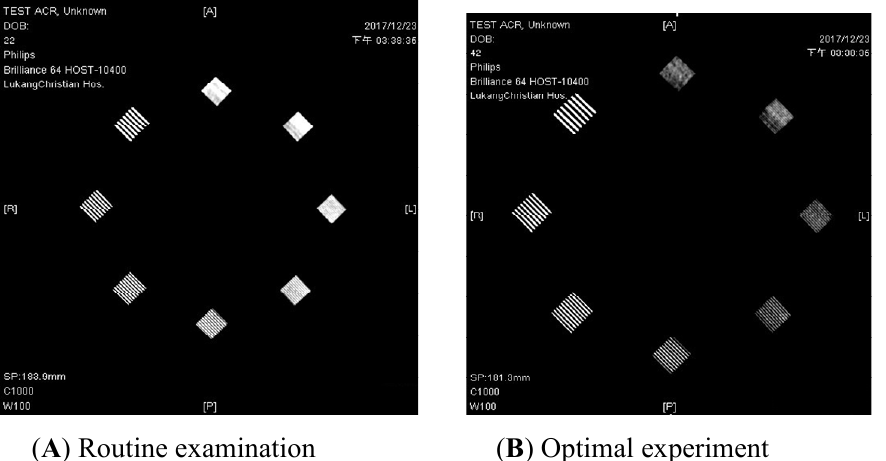
Figure 6. Contrast resolution image from ( A ) the routine examination and ( B ) the optimal experiment using the ACR CT accreditation phantom. The window acquisition is 100 and the level acquisition is 1000. The mean spatial resolution is 8.0 ± 0.00 line pairs/cm and 9.33 ± 0.50 line pairs/cm, respectively.